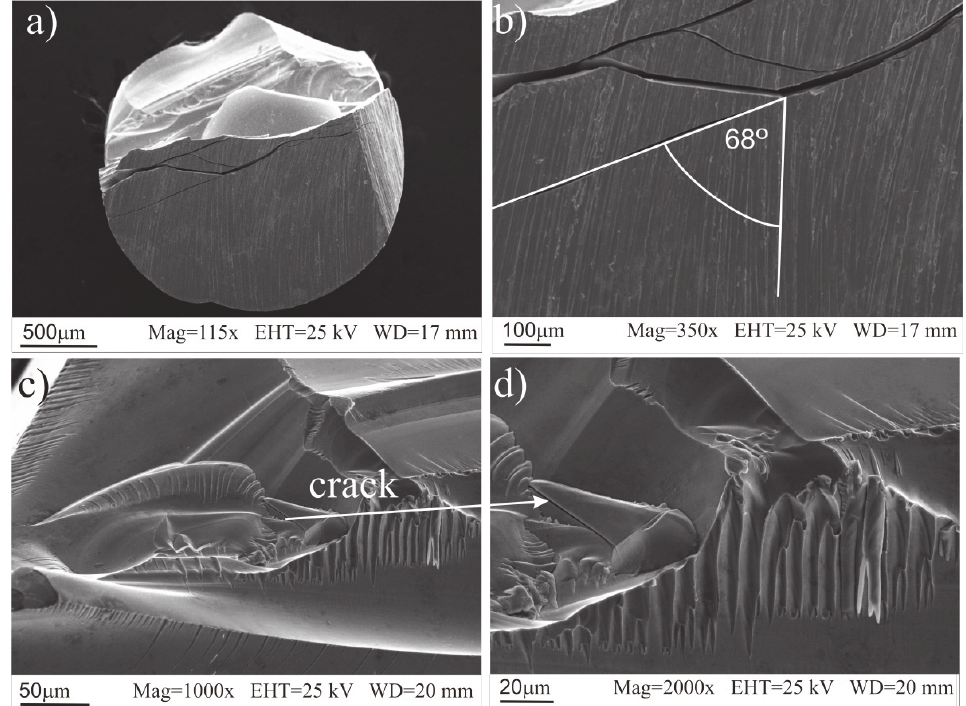
Figure 3: SEM images of the fracture morphology of Fe 36 Co 36 B 19 Si 5 Nb 4 alloy rod with diameter of  =2 mm after compressive fracture; a – main view: smooth and vein pattern regions, b – image of fracture outside surface, vein patterns, many cracks c – image of fracture of near the core of rod, smooth and vein pattern regions, clear crack, d – image of (c) at higher magnification. White arrow indicates the crack